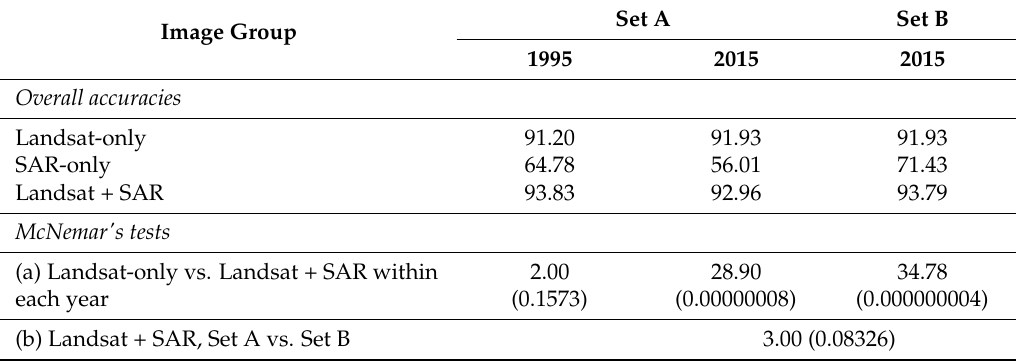
Table 4. Overall accuracies (%) from the classification results for each set and each image group, and results of the McNemar’s tests for ( a ) Landsat-only vs. Landsat + SAR data for each set, and for ( b ) Set A vs. Set B data for the 2015 Landsat + SAR data. Results of the McNemar’s tests show the z -scores and p -values (in